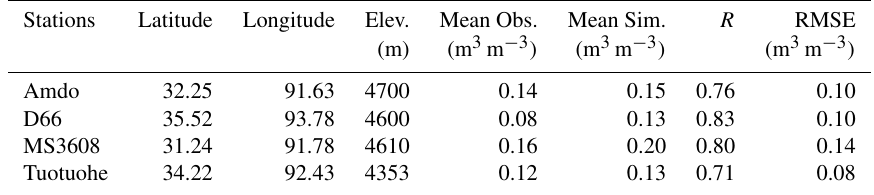
Table 4. Statistics of the first layer (0–40cm) monthly soil moisture. The observation period is August 1997–September 1998.